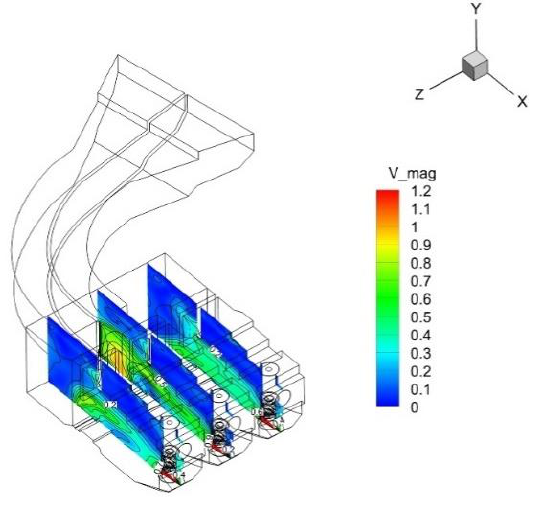
Figure 11. Plan 3 isogram of velocity. ( a ) Center section of pump body along flow direction. ( b ) Center section of pump body in vertical flow direction.